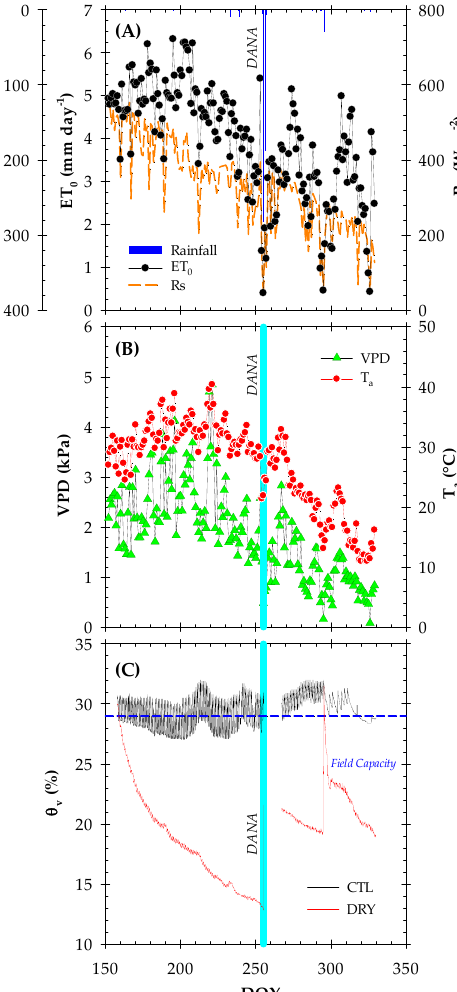
Figure (cid:561) 1. (cid:561) The (cid:561) time (cid:561) course (cid:561) of (cid:561) ( A ) (cid:561) reference (cid:561) crop (cid:561) evapotranspiration (cid:561) (ET 0 ), (cid:561) rainfall (cid:561) and (cid:561) solar (cid:561) radiation (cid:561) Figure 1. The time course of ( A ) reference crop evapotranspiration (ET 0 ), rainfall and solar radiation (Rs), (cid:561) ( B ) (cid:561) vapor (cid:561) pressure (cid:561) deficit (cid:561) (VPD) (cid:561) and (cid:561) daily (cid:561) mean (cid:561) air (cid:561) temperature (cid:561) (Ta) (cid:561) and (cid:561) ( C ) (cid:561) volumetric (cid:561) soil (cid:561) water (cid:561) content (cid:561) ( (cid:908) v ) (cid:561) at (cid:561) 0–0.5 (cid:561) m (cid:561) soil (cid:561) depth (cid:561) during (cid:561) the (cid:561) postharvest (cid:561) period (cid:561) (June (cid:561) to (cid:561) November, (cid:561) DOY (cid:561) (Rs), ( B ) vapor pressure deficit (VPD) and daily mean air temperature (Ta) and ( C ) volumetric 158–340) (cid:561) in (cid:561) the (cid:561) CTL (cid:561) (full (cid:442) irrigated) (cid:561) and (cid:561) DRY (cid:561) (non (cid:442) irrigated) (cid:561) treatments. (cid:561) Values (cid:561) are (cid:561) the (cid:561) 15 (cid:442) min (cid:561) rec (cid:556) soil water content ( θ v ) at 0–0.5 m soil depth during the postharvest period (June to November, ords (cid:561) corresponding (cid:561) to (cid:561) the (cid:561) average (cid:561) of (cid:561) four (cid:561) capacitance (cid:561) probes. (cid:561) The (cid:561) dashed (cid:561) horizontal (cid:561) blue (cid:561) line (cid:561) de (cid:556) limits (cid:561) the (cid:561) field (cid:561) capacity. (cid:561) The (cid:561) solid (cid:561) vertical (cid:561) cyan (cid:561) line (cid:561) indicates (cid:561) the (cid:561) DANA (cid:561) event. (cid:561) DOY 158–340) in the CTL (full-irrigated) and DRY (non-irrigated) treatments. Values are the 15-min records corresponding to the average of four capacitance probes. The dashed horizontal blue line delimits the field capacity. The solid vertical cyan line indicates the DANA